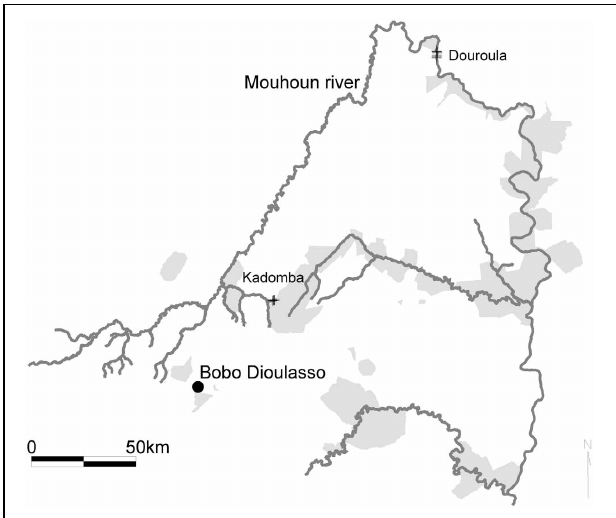
FIGURE 1 | Location of the study sites in the Mouhoun river basin, Burkina Faso. The gray areas correspond to the protected forests.